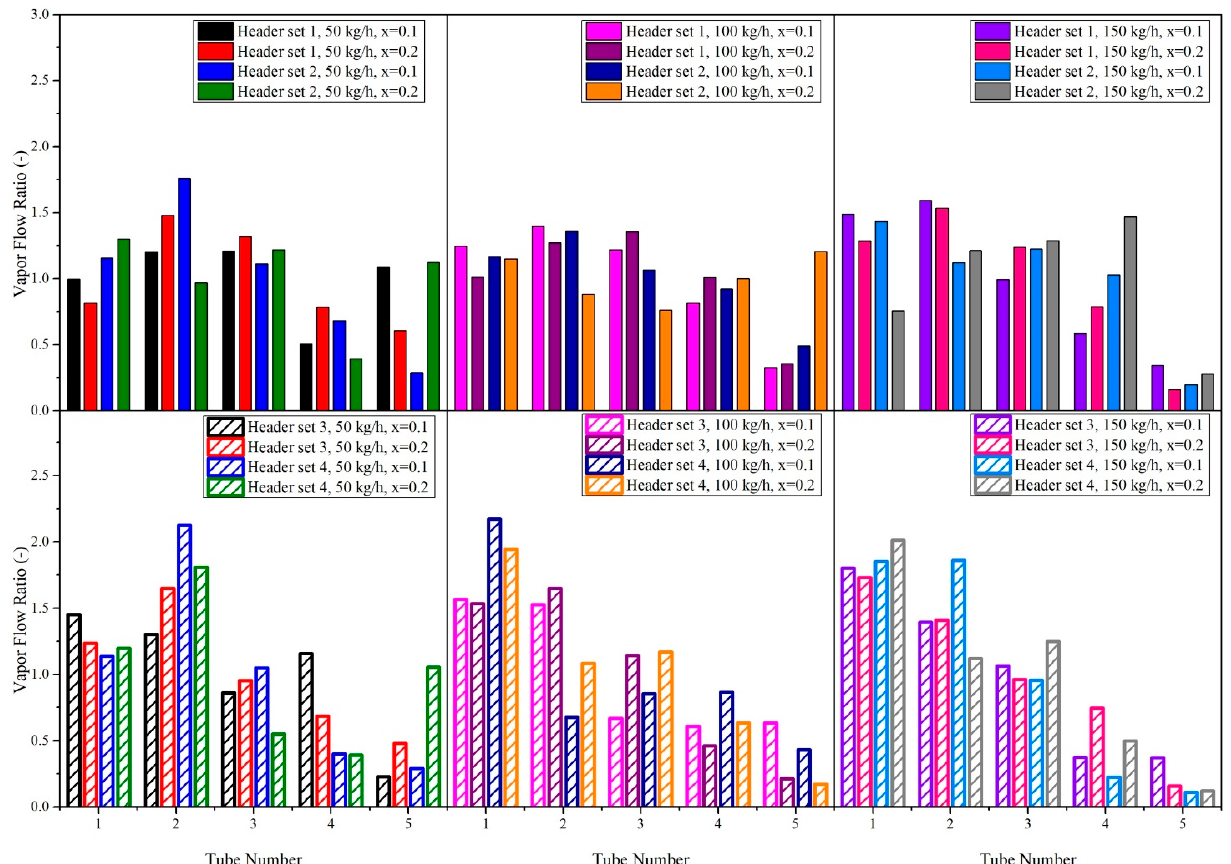
Figure 5. Vapor flow ratio of the four vertical headers.